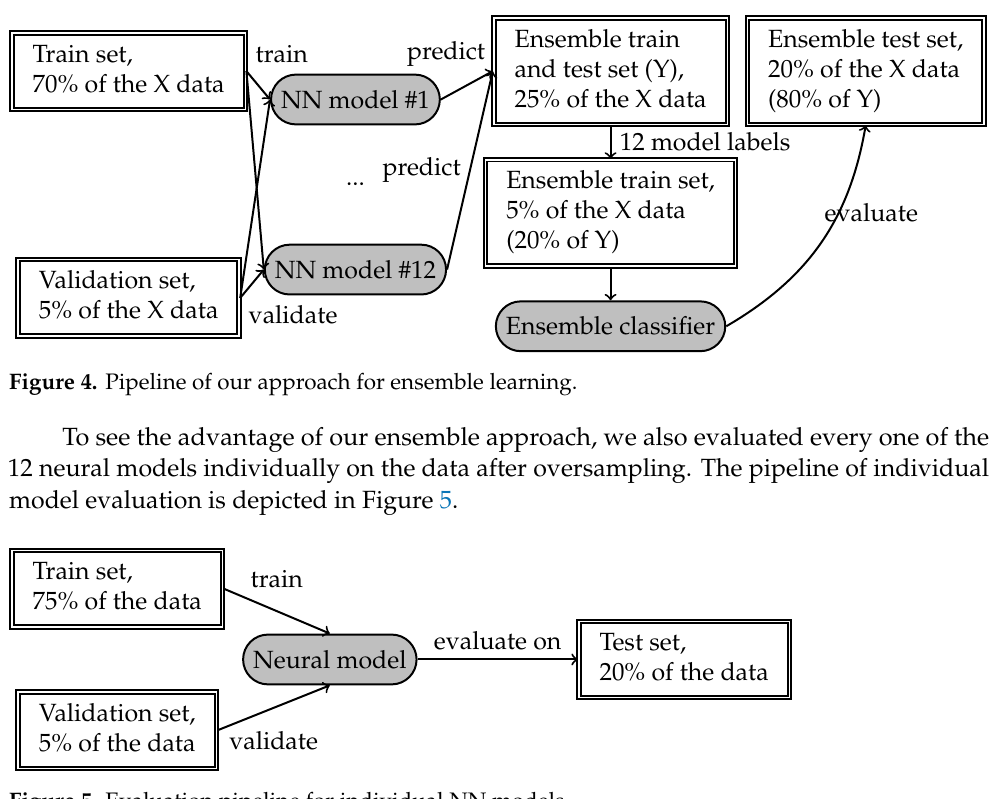
Figure 5. Evaluation pipeline for individual NN